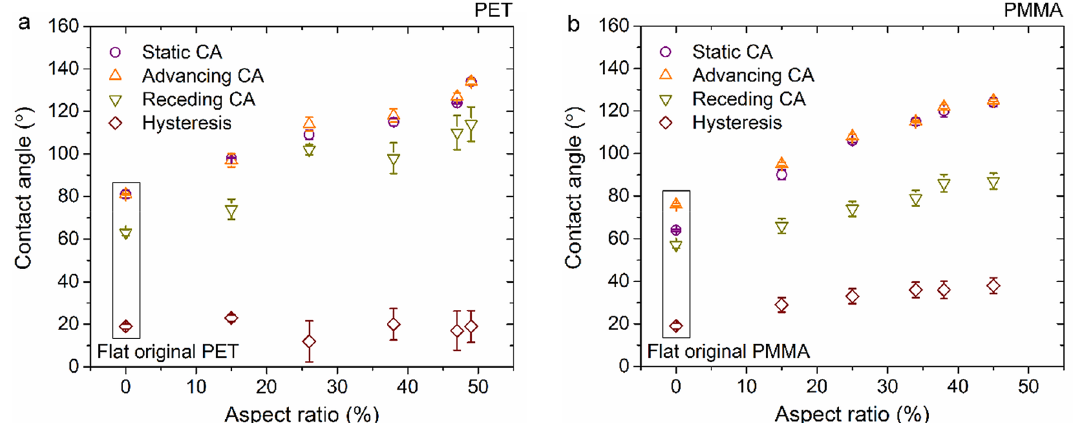
Figure 6. Static contact angles, advancing/receding contact angles, and hysteresis for water on flat and structured ( a ) PET and ( b ) PMMA with various texture aspect ratio and fixed period of 2.6